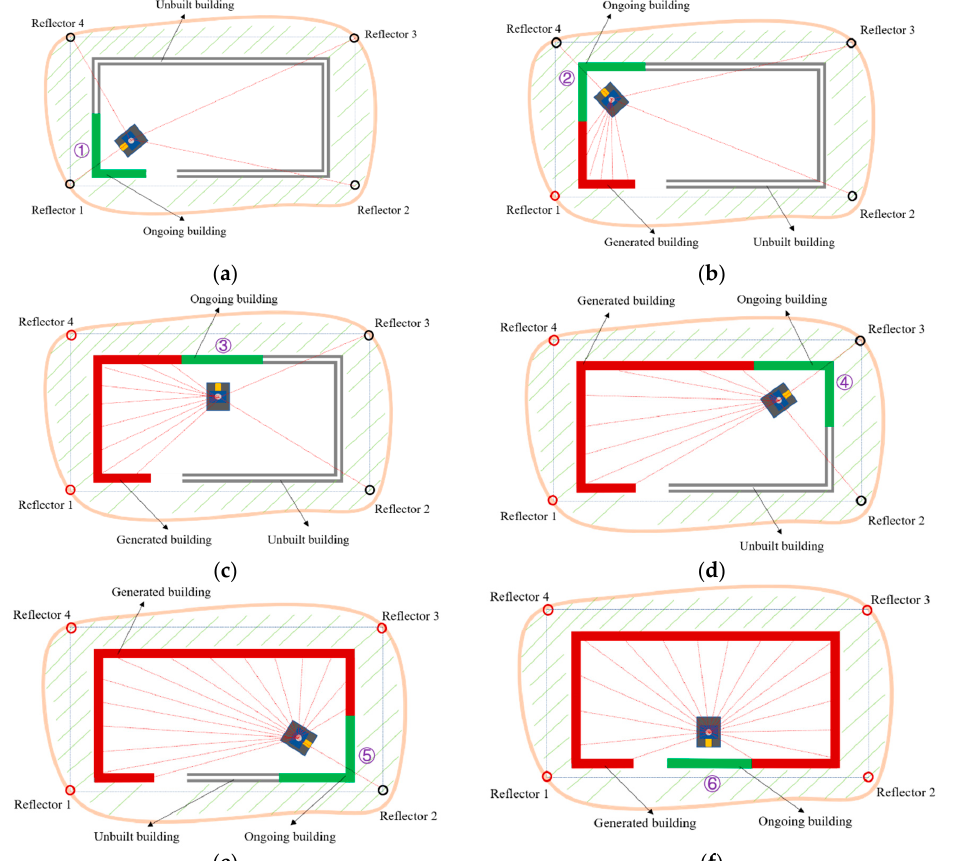
Figure 6. Localization flowchart of mobile robot at locations of 1 (cid:79) ~ 6 (cid:79) . ( a ) The initial location 1 (cid:79) of the ongoing scene; ( b ) The working location 2 (cid:79) with artificial landmarks and ongoing buildings; ( c ) The working location 3 (cid:79) with artificial landmarks and ongoing buildings; ( d ) The working location 4 (cid:79) with artificial landmarks and ongoing buildings; ( e ) The working location 5 (cid:79) with artificial landmarks and ongoing buildings; ( f ) The last working location 6 (cid:79) of the ongoing